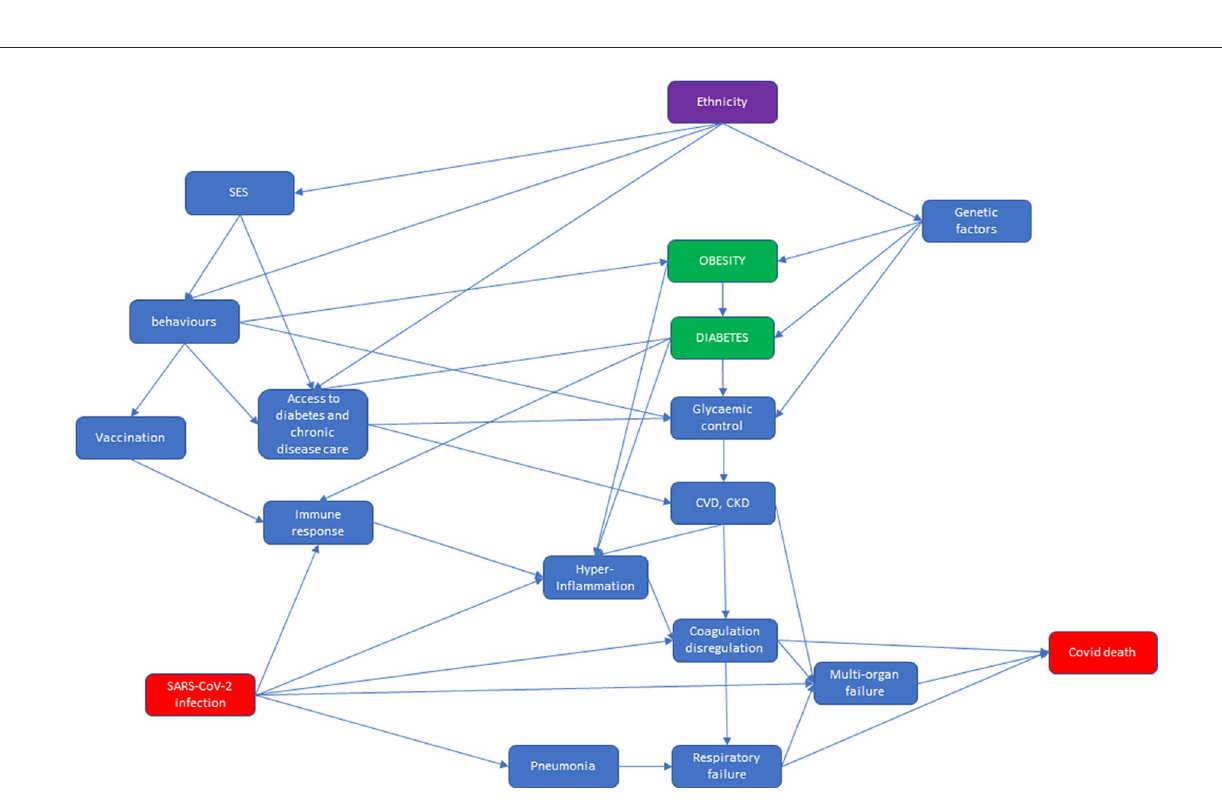
FrontiersinPublicHealth